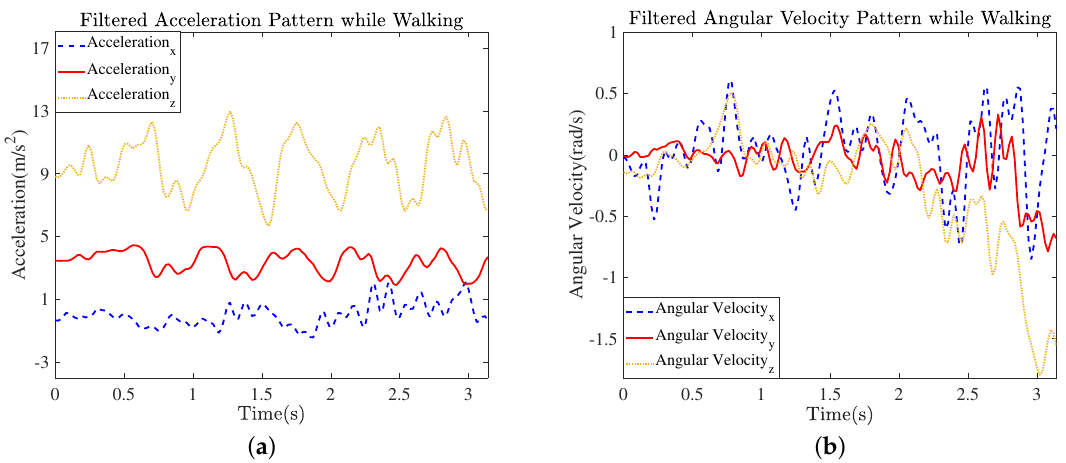
Figure 5. Filtered signals of accelerometers and gyroscope sensors: filtered signal patterns of ( a ) bodily acceleration and ( b ) angular velocity while